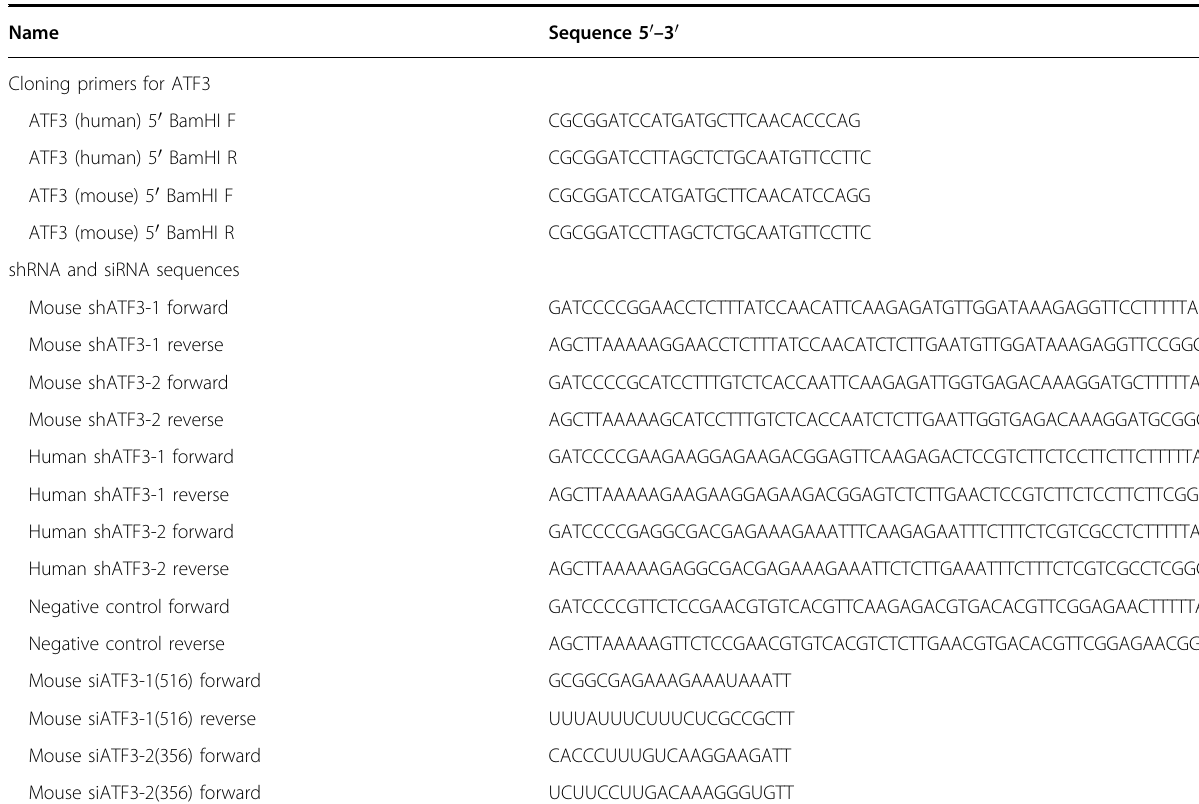
Table 1 Cloning primers for ATF3, and shRNA and siRNA